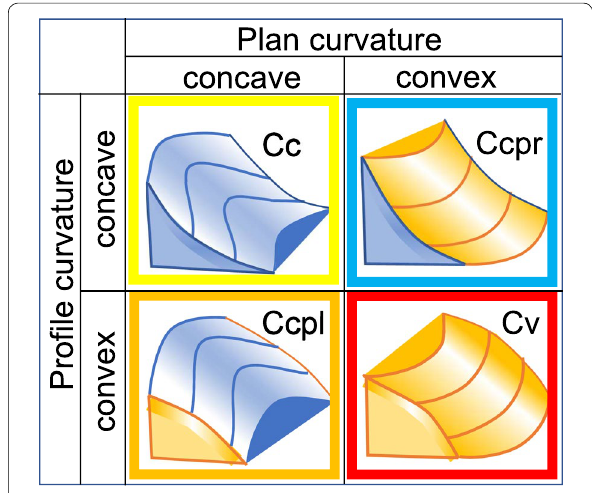
Fig. 9 Schematic diagram of slope types classified based on the profile and planform curvatures of each